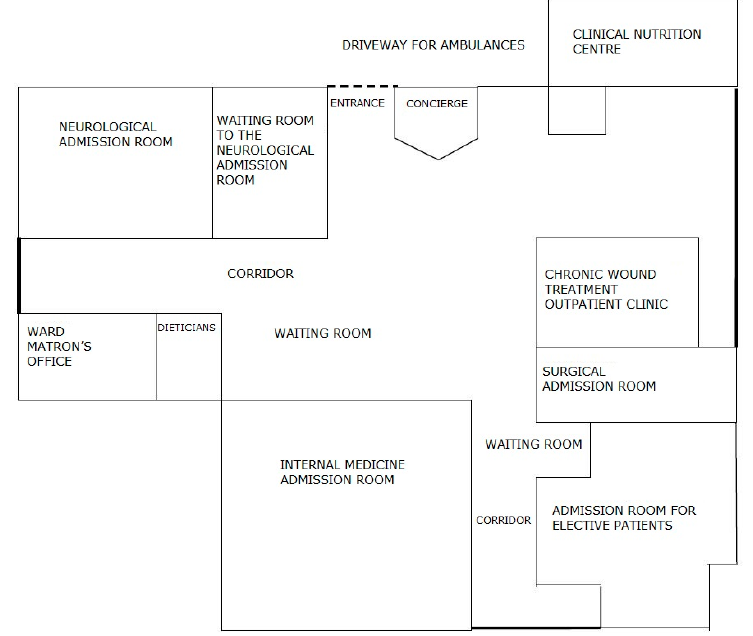
Figure 5. The diagram showing the places in the admission room before the changes were made.